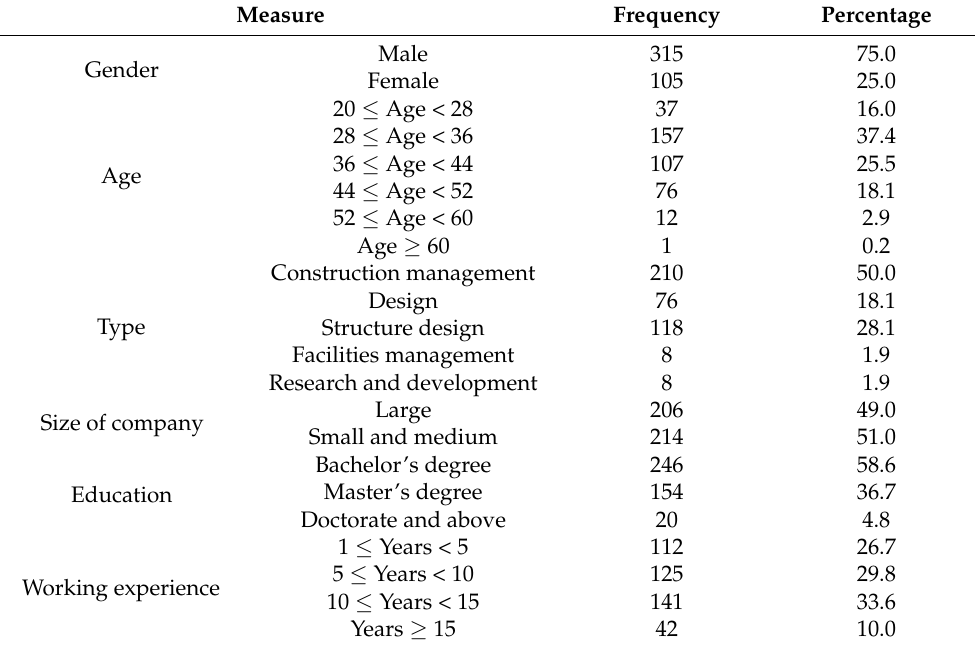
Table 3. Demographics of respondents (N =